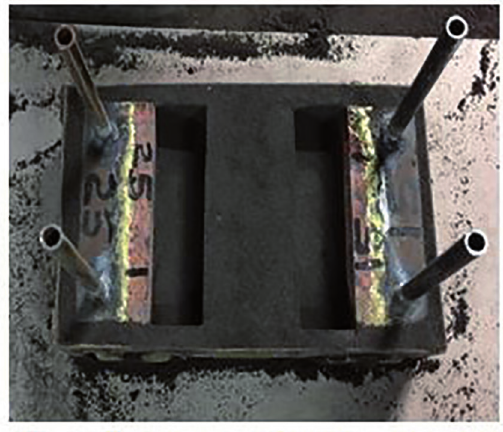
Figure 2: Sand mould with Copper end chill and arrangements for passing liquid nitrogen.